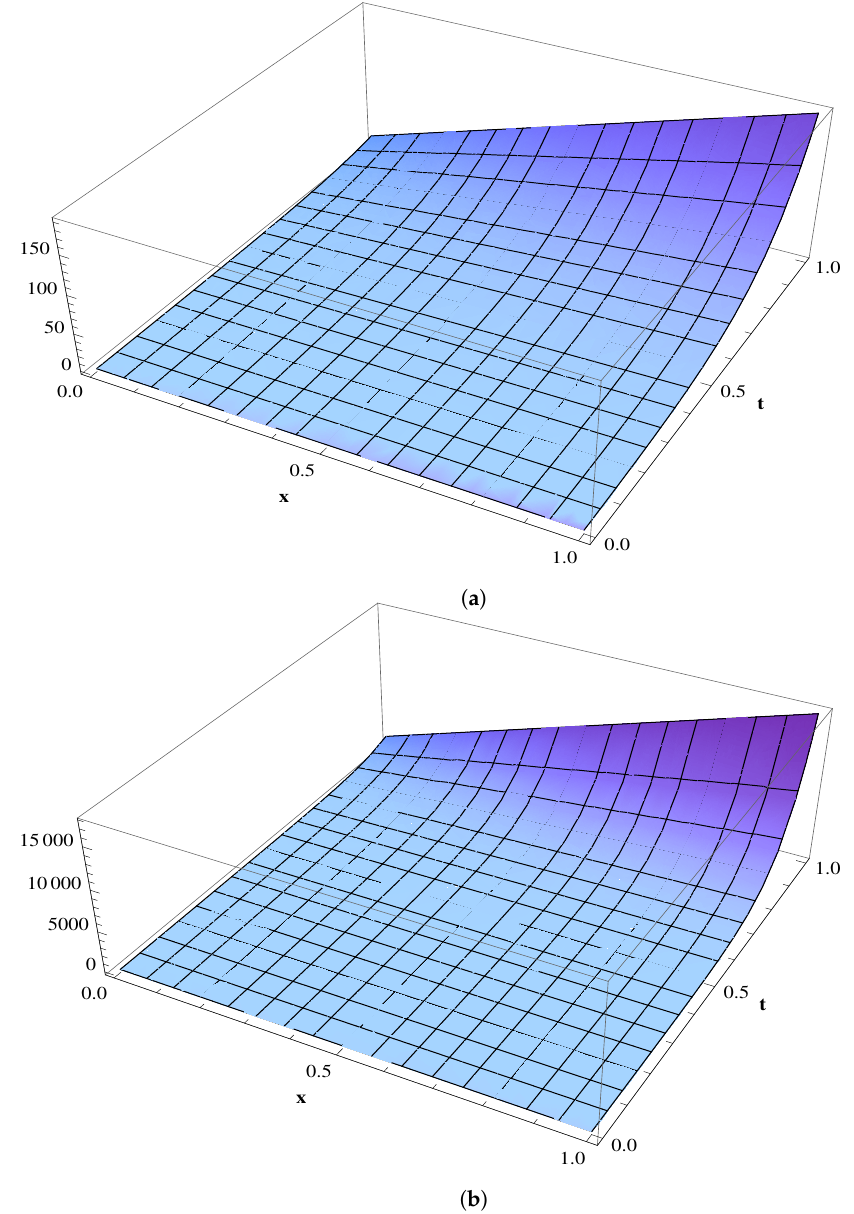
Figure 6. The FRDTM solutions f ( x , y , t ) : ( a ) β = 0.7 and ( b ) β =